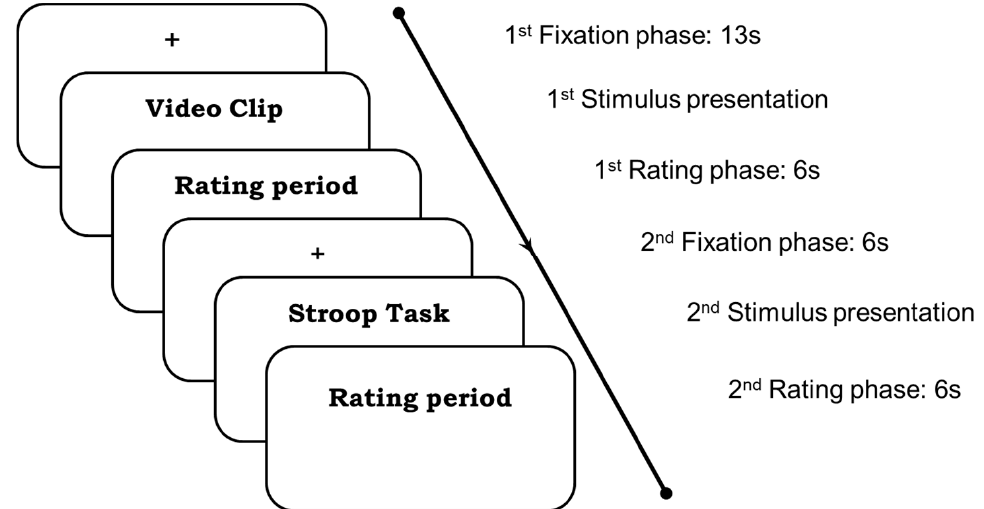
Figure 2. Schematic illustration of an experimental trial .